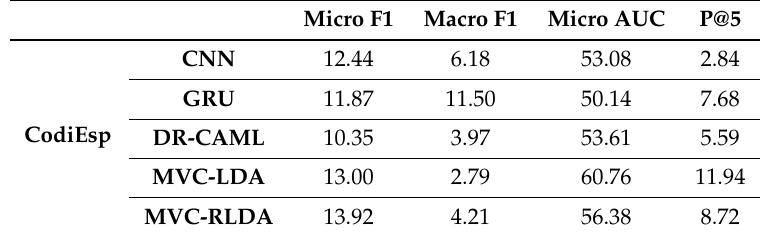
Table 8. Results of hierarchical models for top 50 codes obtained on the CodiEsp dataset.